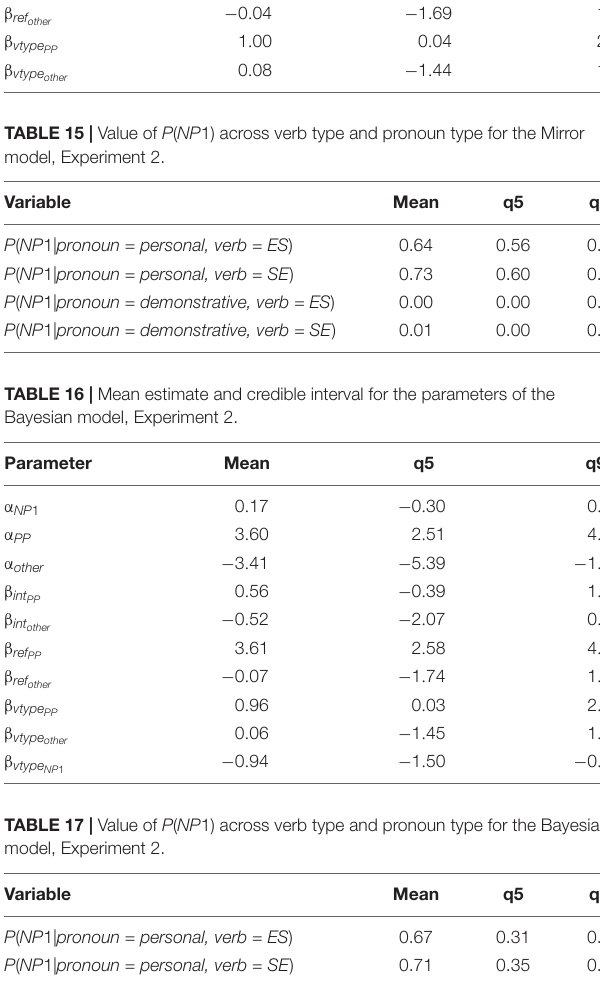
The table is ordered by the expected log-predictive density (elpd) score of the models, with a higher score indicating better predictive accuracy. The highest scoring model is used as a baseline for the difference in elpd (elpd_diff) and the difference standard error (se_diff). “Weight” represents the weights of the individual models that maximize the total elpd score of all the